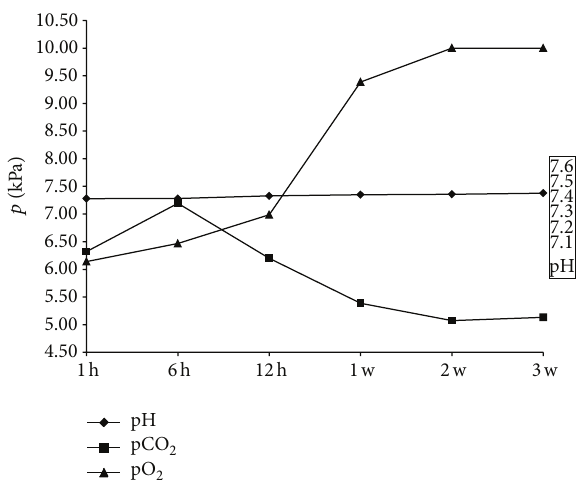
Figure 10: Change of arterial blood-pH; pCO 2 and pO 2 values of subject group A (𝑛 = 15) within the whole research period (values in 𝑥 + 𝑠